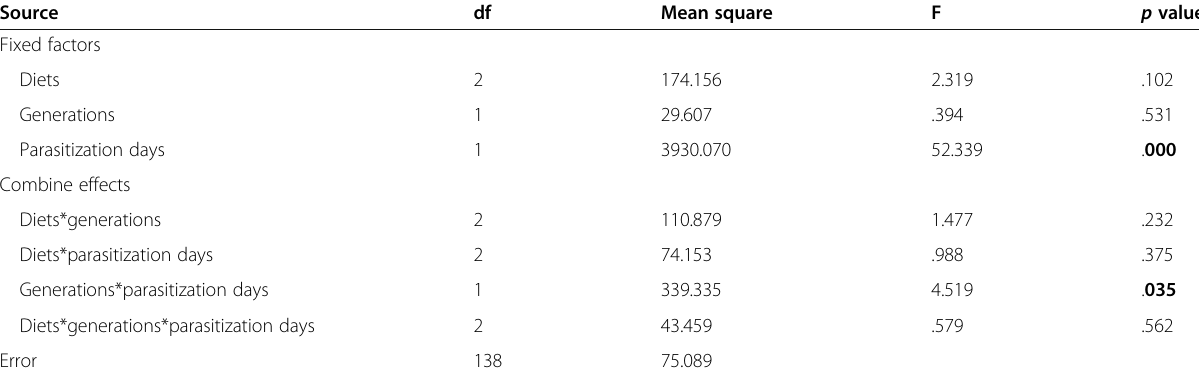
different diets